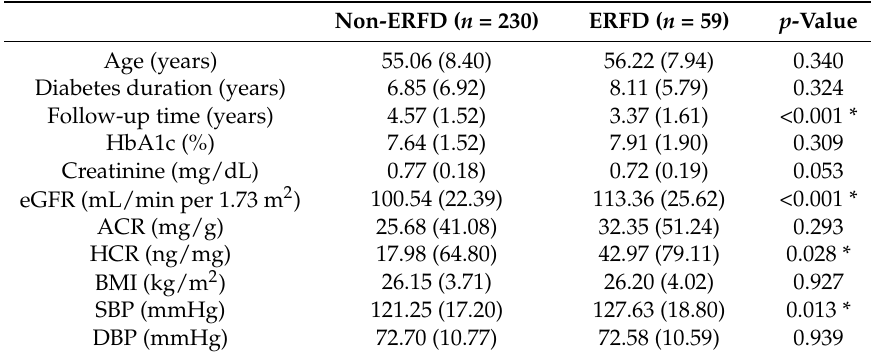
Table 2. Demographic and clinical characteristics of type 2 diabetes patients for evaluation of the role of haptoglobin on early renal function decline